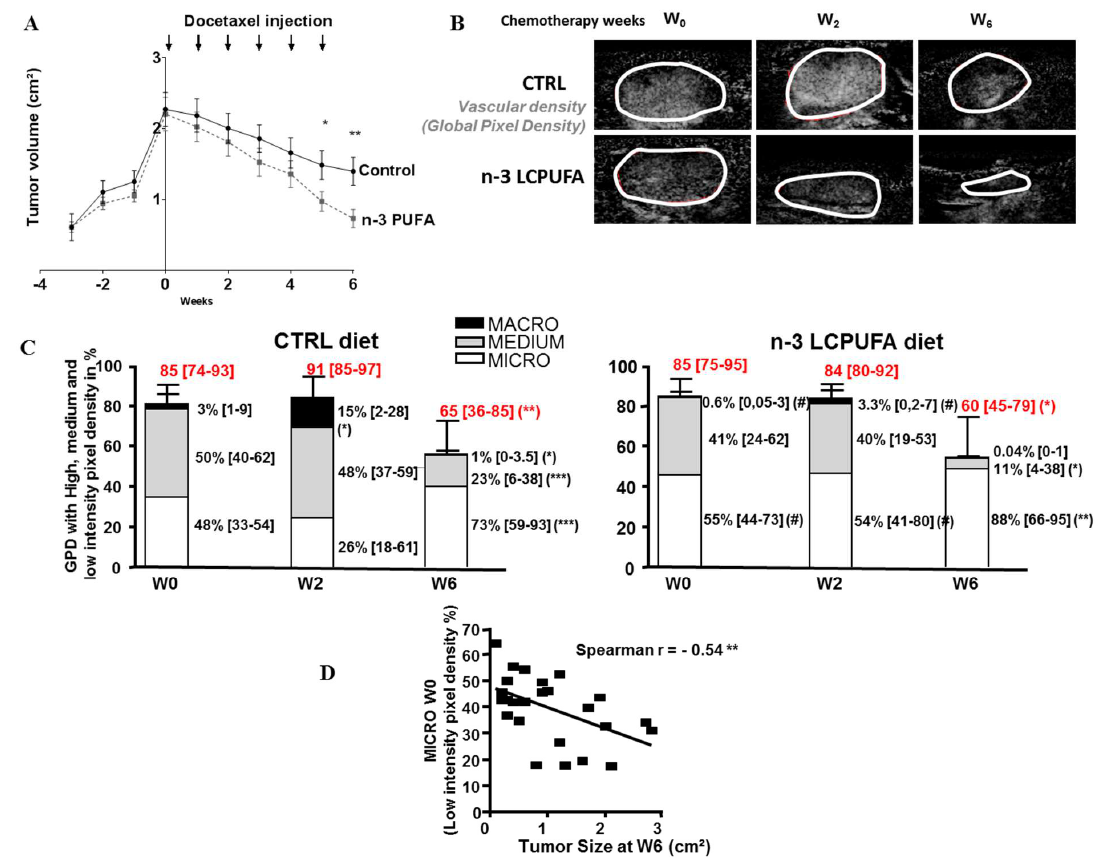
Figure 2. An n-3 LCPUFA-enriched diet maintains a microvascular compartment preponderance during docetaxel treatment. When tumors reached 2 cm 2 , docetaxel was injected (6mg / kg / week) every week for 6 weeks and tumor vascularization was quantified by CEUS methodology before (W0), or two weeks (W2) and six weeks (W6) after the beginning of docetaxel therapy ( n = 14/nutritional group). Magnification factor: 1.5×. ( A ) Curves of tumors volumes (cm²) according to time (weeks). Tumor size was measured once a week for 6 weeks (mean ± SEM, n = 14) ( B ) Representative images obtained by CEUS showing GPD reflecting global vascular density within tumor of control or n-3 LCPUFA group ( C ) Histograms showing GPD (with its quantification in red) subdivided into three compartments: micro- (low intensity pixel density), medium- (medium intensity pixel density) and macro- (high intensity pixel density) vascularization in control and n-3 LCPUFA groups at W0, W2 and W6 (bar and values on the right: median and interquartile range, 25–75th percentile). * p < 0.05, *** p < 0.001 (compared to W0 in the same dietary group, paired t-test); # p < 0.05 (compared to control nutritional group at the corresponding time points, Mann–Whitney test). ( D ) Correlation between microvascularization measured before chemotherapy at W0 (%) and tumor size at the end of the chemotherapeutic treatment (W6). Points represent individual data (Spearman test, ** p <